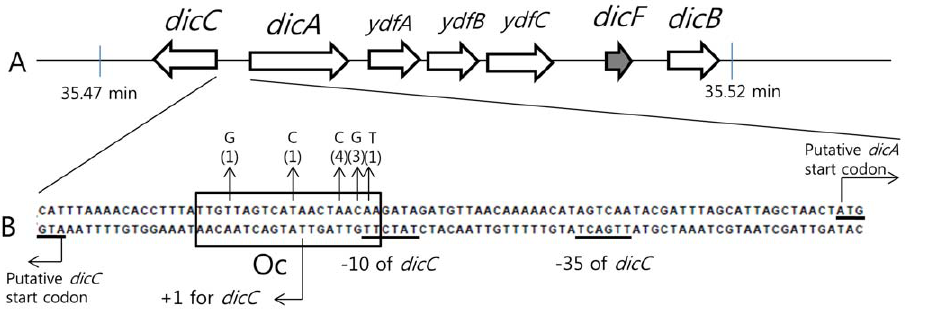
Figure 5. Relative location of dic genes on the E.coli chromosome and DNA sequence of the promoter region of the dicA and dicC genes ( PdicAC ). (A) A portion of the Qin prophage in the E. coli genome between 35.47 and 35. 52 min is shown with genes involved in cell division inhibition [27]. Arrows indicate the direction of transcription and relative size of the genes. The dicF gene produces RNA only [30]. (B) DNA sequence of the promoter region of the dicA and dicC genes is shown. The putative DicA-binding site (Oc) is boxed. The nucleotide changes detected in a few cloned PdicAC DNA fragment are shown above the arrows with numbers in parentheses that indicate the number of incidents. A putative 2 10 and 2 35 promoter sequence of the dicC gene is underlined. The transcription initiation site of the dicC gene is indicated as + 1 for dicC (Fig. S3). The promoter sequence for the dicA gene is not obvious with DNA sequence information only.